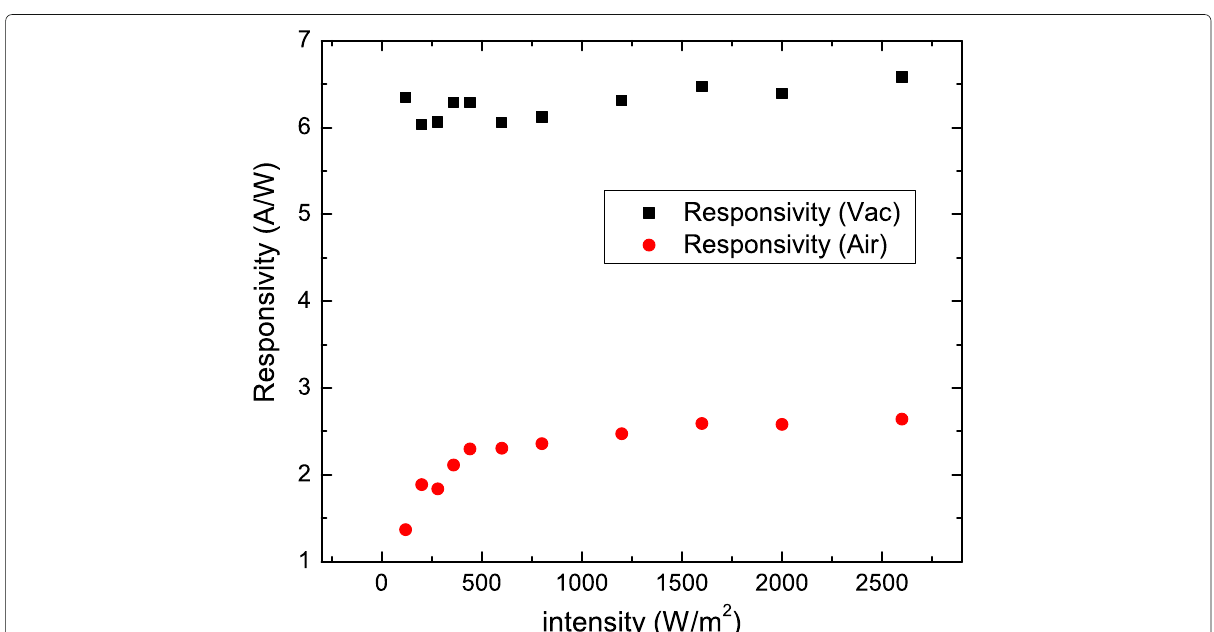
Fig. 5 Responsivity and photoconductive gain as functions of the light power intensity at a wavelength of 532 nm. The responsivity is weak light power intensity dependence in vacuum. The responsivity decreases as the light power intensity decreases in atmosphere when the light power intensity is lower than 500 W / m